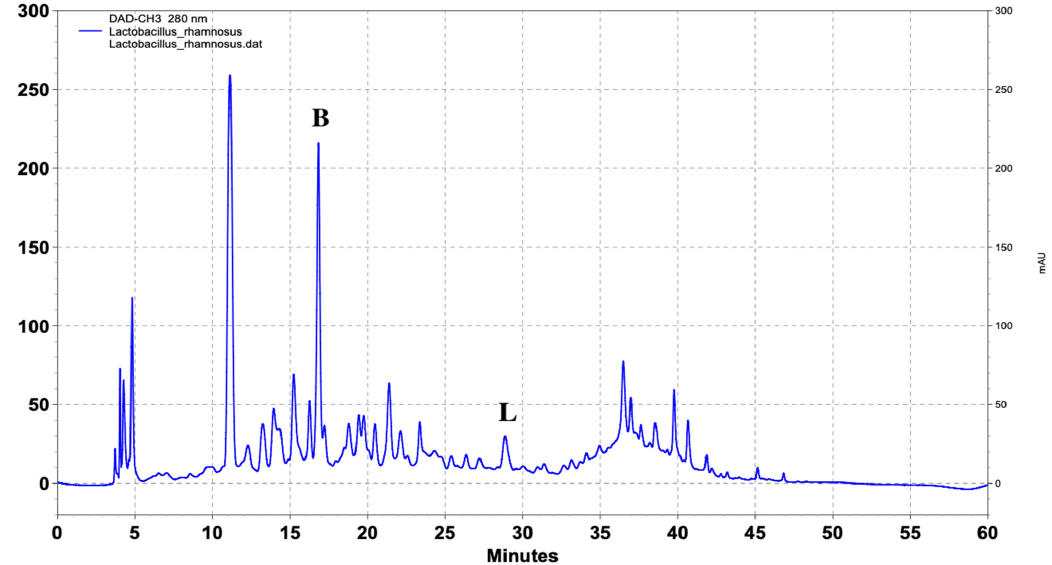
Figure 4. Chromatographic profile of Lacticaseibacillus rhamnosus GG ATCC53103 showing antimicrobial activity. High mass accuracy spectrum of compound (B) OH-PLA (16.3 min); high mass accuracy spectrum of compound (L) Ferulic acid (28.7 min).